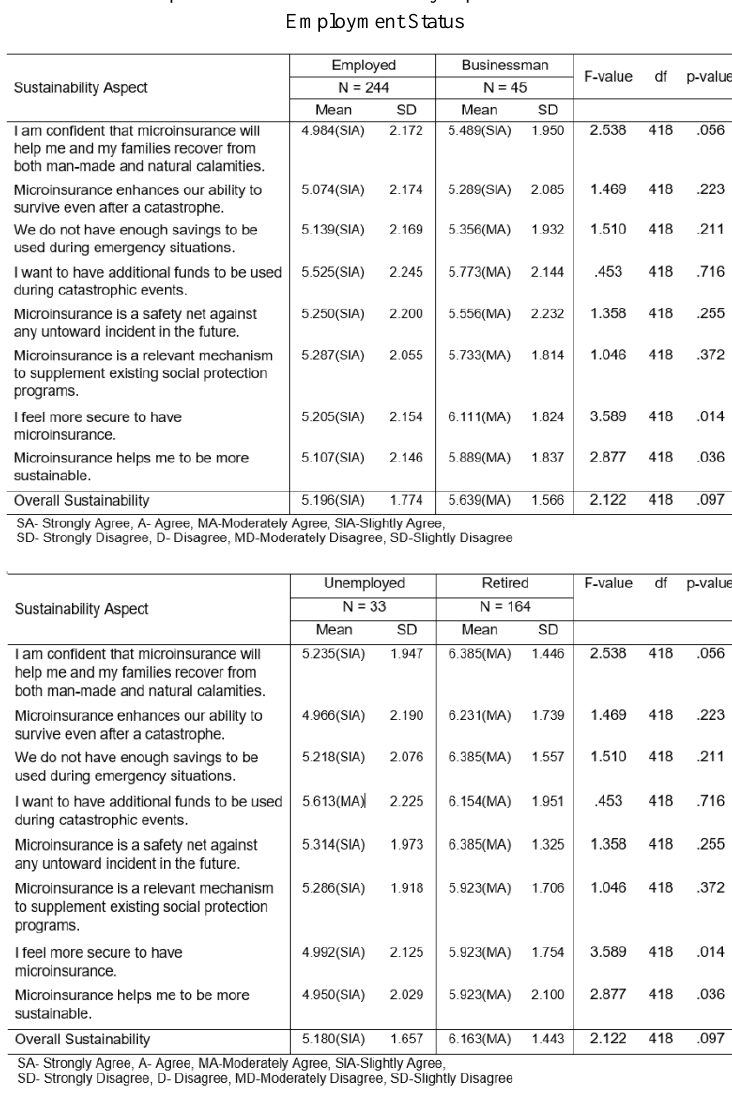
Table 3: Level of Agreement of the Respondents on the Sustainability aspect of Microinsurance When Grouped According